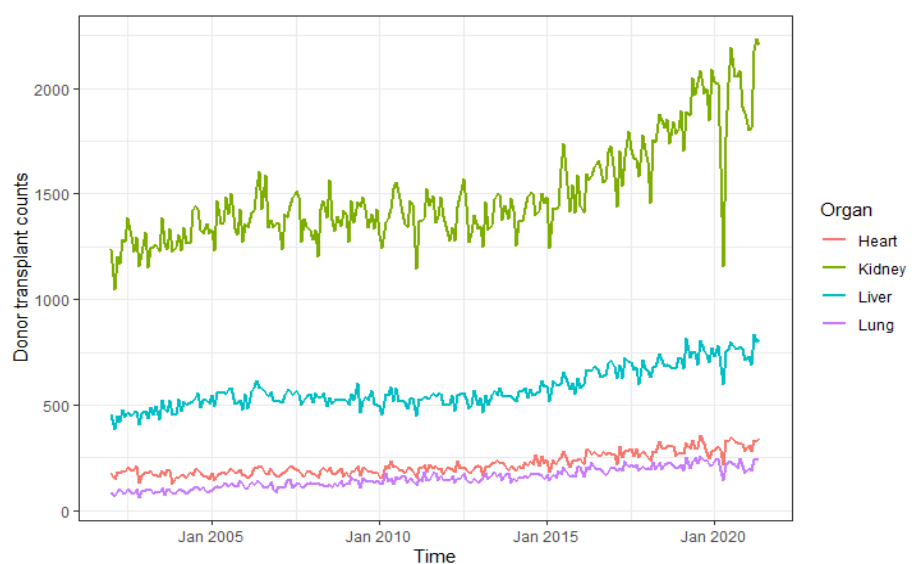
Figure 6. Donor transplant counts in the US by organ, based on OPTN data as of November 2021. A SARIMA ( 0, 1, 2 ) × ( 0, 1, 1 ) 12 model with two intervention effects, namely, the oc- currence of COVID-19 in March 2020 and the introduction of the kidney allocation policy in March 2021 in Equation (5) was fit to the kidney donor series from January 2002 to August 2021. The model fit plotted in the top panel of Figure 7 follows the observed kidney transplant trend very closely. The estimated effects of both COVID-19 and kidney allocation policy change are shown in the bottom panel of Figure 7.